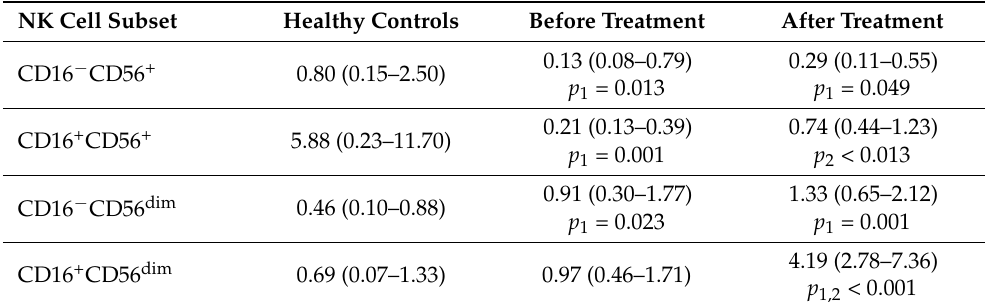
Table 2. Major peripheral blood NK cell subsets (%) in convalescent COVID-19 individuals before and after recombinant human IL-2 treatment (Me (IQR)). NK Cell Subset Before